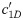
Empirical forelimb GRF (black) compared to model predictions for a range of force-rate penalty coefficients (c1D′).(A) At lower c1D′, the solution becomes more impulsive, as expected from a work-minimizing “bang-coast-bang” solution [23]. As c1D′ increases, the force peaks become more shallow, but in all cases the optimal solution maintains the double-hump profile characteristic of walking bipeds and quadrupeds under most situations. (B) The actuation is seemingly elastic, as indicated by the negative linear relationship between force and leg length change, for small changes in leg length from resting. However, there are no springs in the model. The “pseudo-elastic” actuation occurs because of the compromise between work and force rate. High force rate penalties lead to only small deviations from pseudo-elastic actuation and low apparent stiffness (k′), and small force rate penalties deviate substantially from pseudo-elasticity with high apparent stiffness. The “hook” in the force-length curve occurs when the leg shifts to stance, modulating the force to ∼0.5 mg. Morphological data for the simulations, and empirical ground reaction forces, are derived from [37] for a Dalmation (see also Fig 5B).